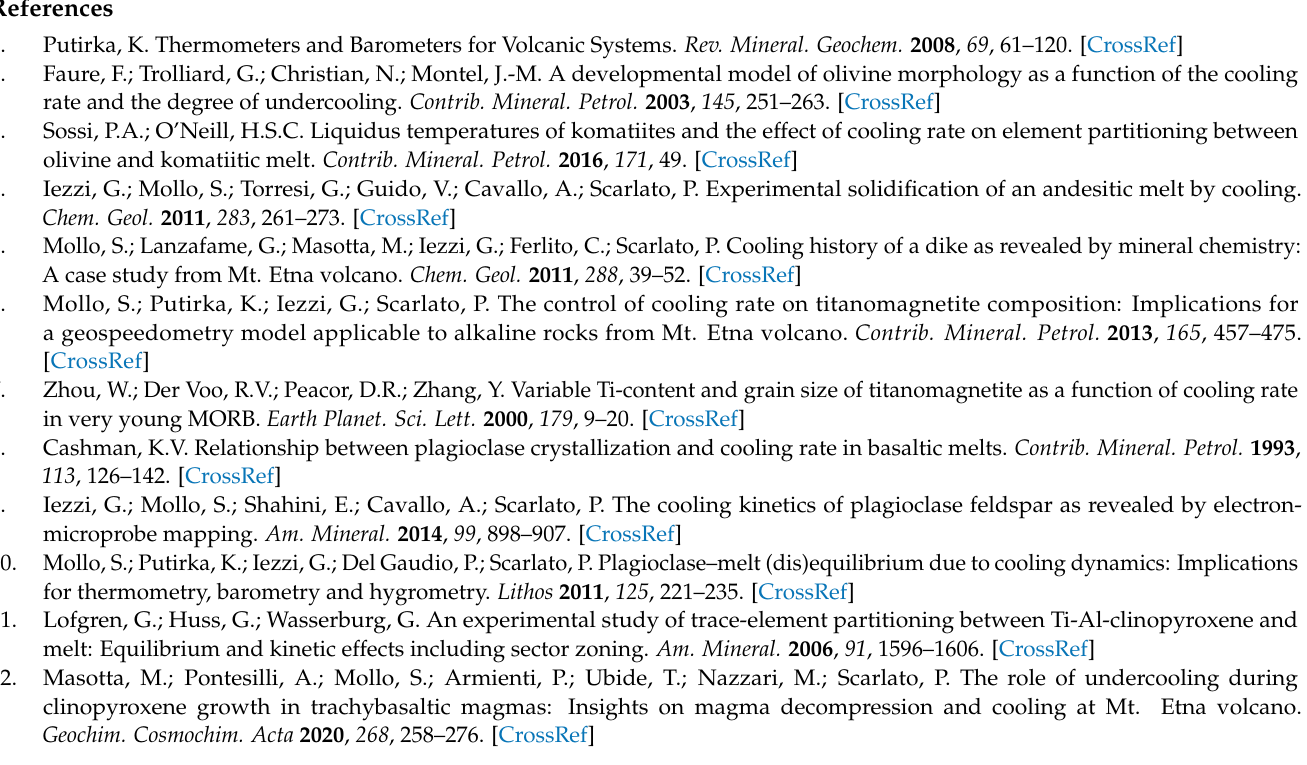
Figure A2. The calculated pressure and temperature. The calculated pressure by Equation (A1) ( ± 1.4 kbar, [101]) and Equation (A2) ( ± 3.1 kbar, [1]). The calculated temperature by Equation (A3) ( ± 28 ◦ C, [108]). The points are all in clinopyroxene–melt equilibrium (Figure A1). The legend is the same as in Figure A1.